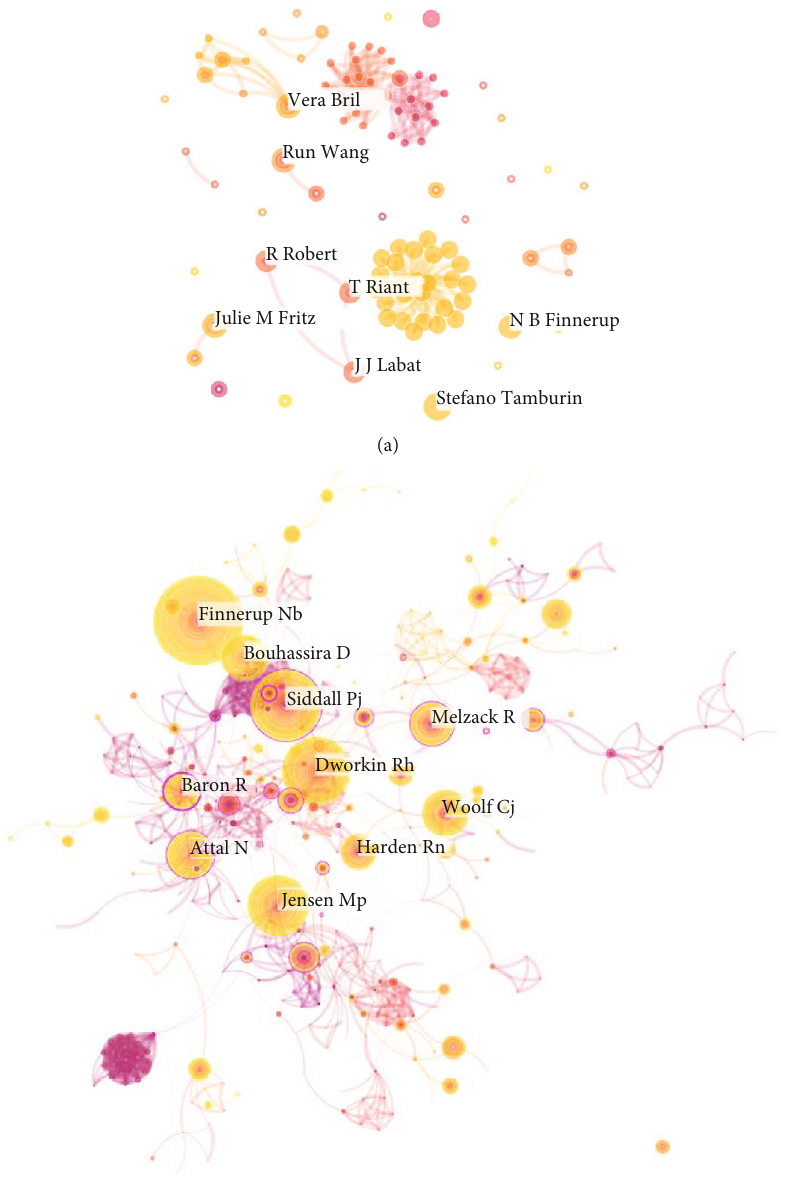
Figure 5: The analysis of authors. (a) Network map of active authors contributed to neuropathic pain rehabilitation research. (b) Network map of cocited authors contributed to neuropathic pain rehabilitation